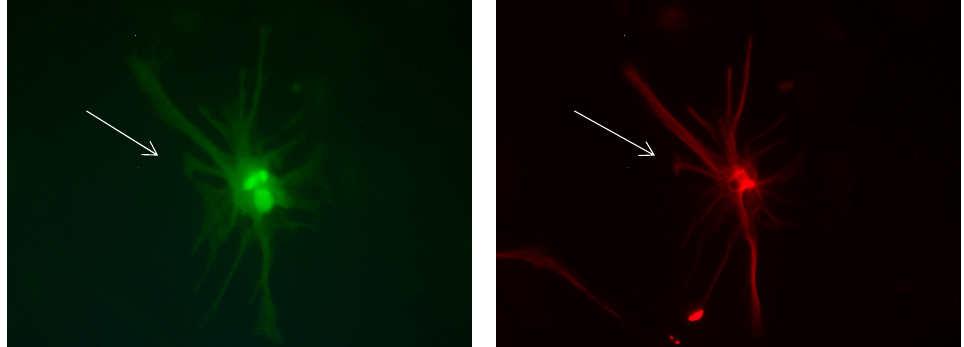
Figure 9. Cultures in a serum-free medium, 5 days (6 after the passage): Immunofluorescence with anti-GFAP (glial fibrillary acidic protein) (red, secondary antibody: donkey anti-goat IgG Alexa Fluor 594), and with anti-Calbindin D28k (polyclonal antibody from the company SWANT) (green, secondary antibody: donkey anti-rabbit IgG Alexa Fluor 488). Epifluorescence microscopy. One giant Calbindin D28k positive and GFAP-positive astrocyte (long arrows) with processes.